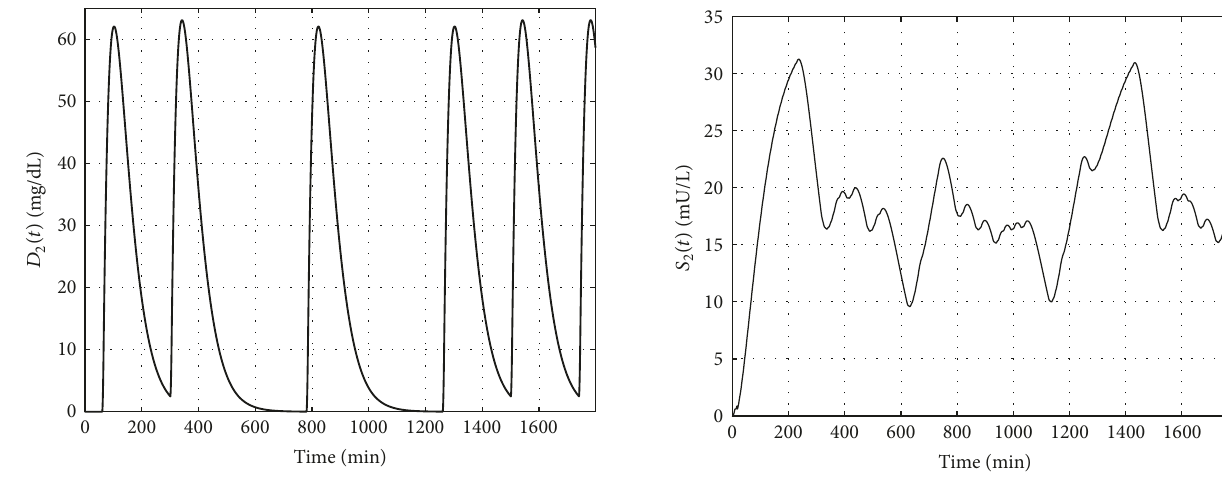
Figure 6: Variation of the second state of the insulin absorption